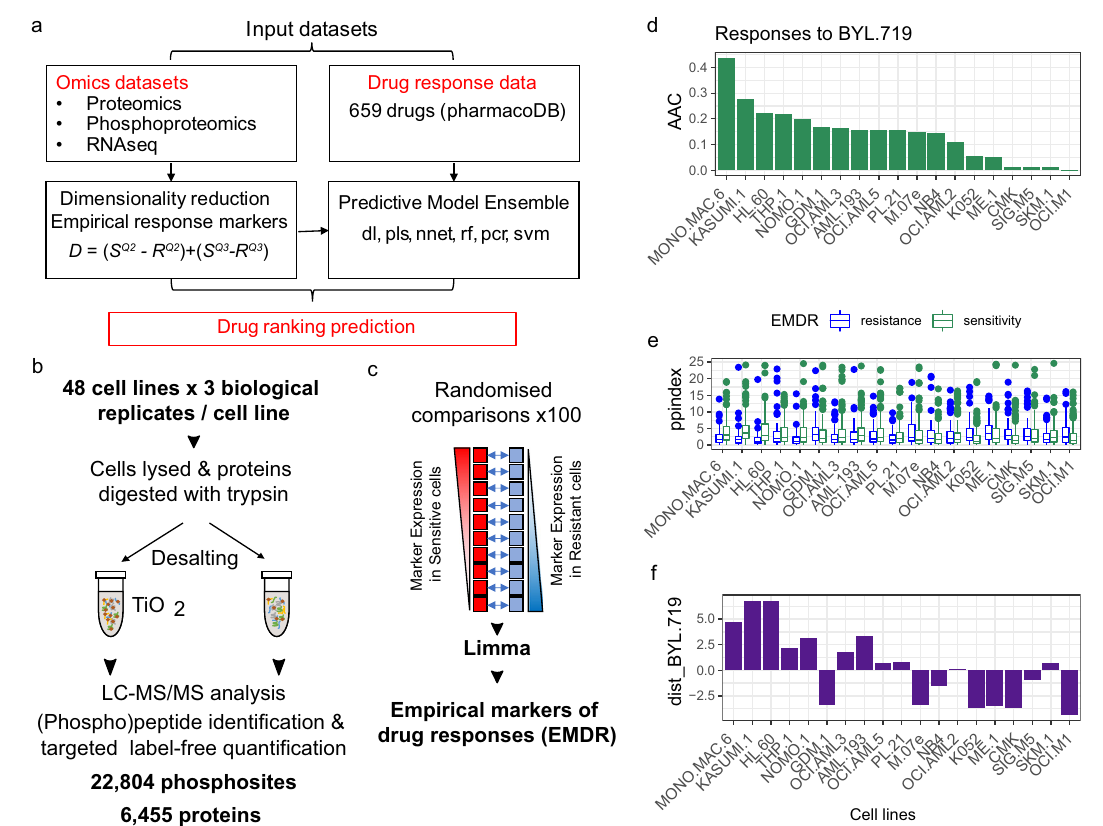
Fig. 1 Overview of Drug Ranking Using Machine Learning (DRUML). a Drug response (AAC) values were modeled for 659 drugs with different DL/ML methods. Of these, 466 produced empirical markers of drug response and the responses for 411 drugs were reliably modeled by at least one learning algorithm. The input for DL/ML model generation are averaged values of empirical markers of drug responses (EMDRs), which are combined to derive a distance metric D . For each drug d and for each biological sample b, D d,b = [(S Q2 -R Q2 ) + (S Q3 -R Q3 )], where S Q2 and S Q3 are median and third quantile expression values of empirical markers increased in cells sensitive to a given drug, respectively; and R Q2 and R Q3 are median and third quartile expression values of empirical markers increased in cells resistant to the same drug. b LC-MS/MS work fl ow for the generation of proteomic and phosphoproteomic datasets used to train DRUML. c Approach to obtain empirical markers of drug responses (EMDRs). d Response values for BYL-719 obtained from PharmacoDB ( n = 19). To determine empirical markers of drug sensitivity and resistance for BYL-719, cell lines are split into sensitive and resistant groups based on area above curve (AAC) values and Empirical Bayes Statistics of linear models were used to identify response markers by resampling. e Boxplot of the distributions of empirical markers of resistance and sensitivity in phosphoproteomics data acquired for the cell lines shown in panel d (measured in triplicate), boxplot with median center, interquartile box boundaries and range upper and lower hinges. f BYL-719 D values for the named cell lines calculated from the EMDR distributions shown in ( e ). Learning algorithms were random forest (rf), cubist, bayesian estimation of generalized linear models (bglm), partial least squares (pls), principal component regression (pcr), support vector machine (svm), deep learning (dl) and neural network